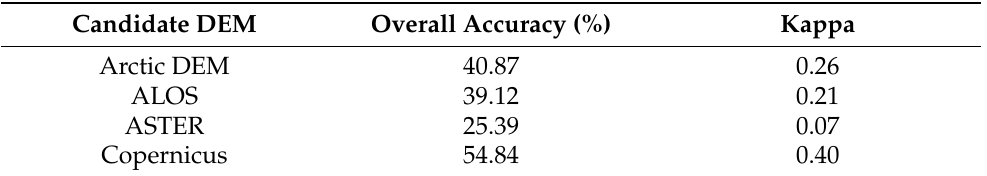
Table 7. Overall accuracy of landform classification from four candidate DEMs when compared with landform map derived from reference